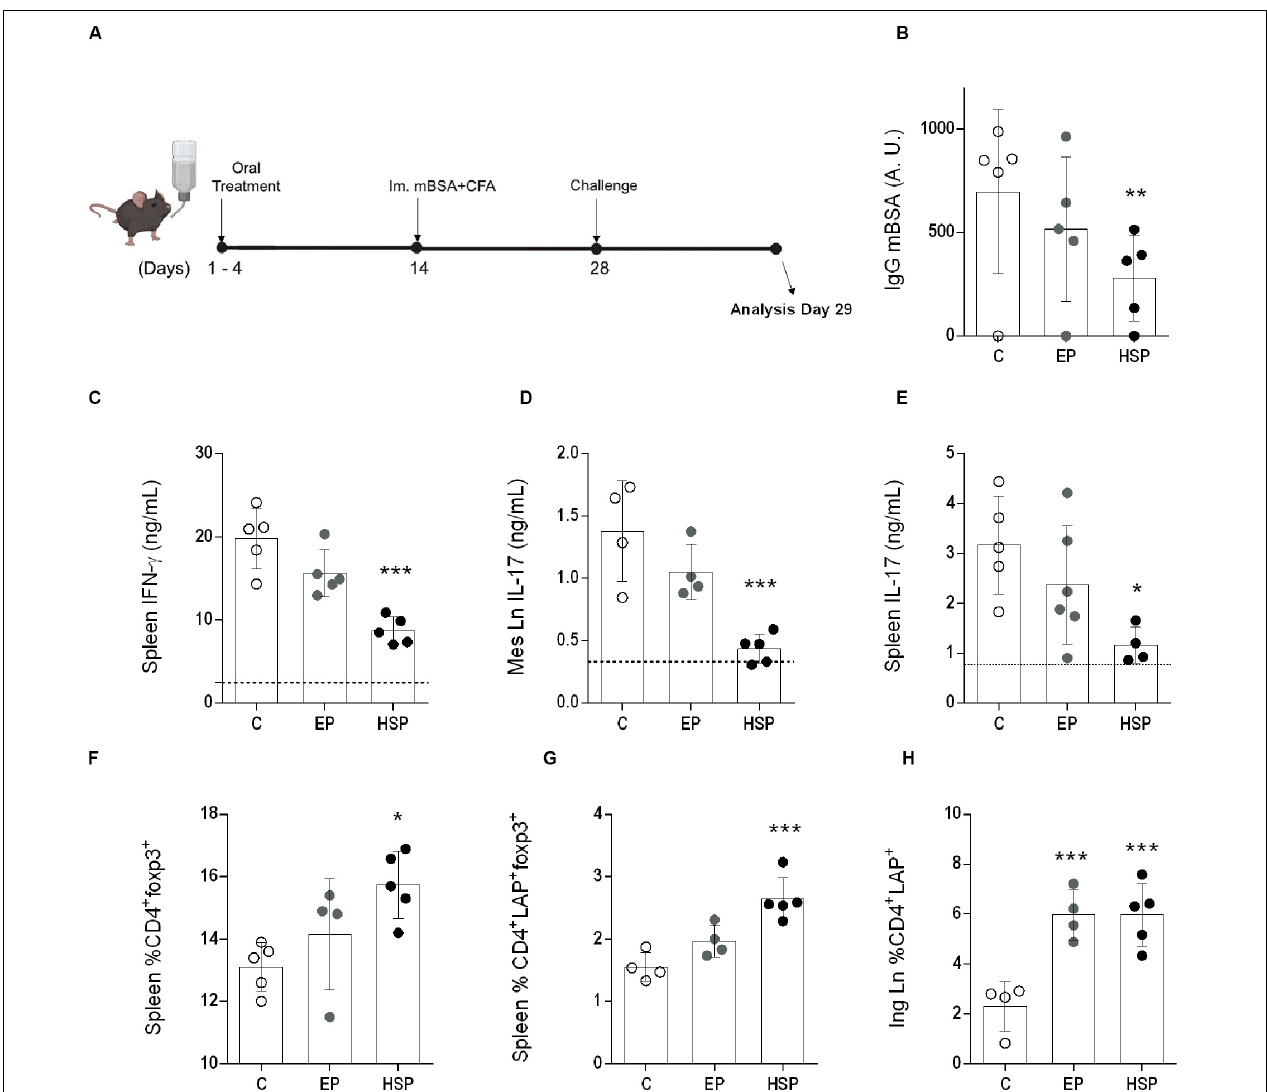
FIGURE 5 | Oral treatment with Hsp65-producing L. lactis prevented mBSA induced arthritis (AIA). (A) Female C57BL/6 mice were fed either XM17 broth (group C), L. lactis -EP (group EP) or Hsp65-Lac (HSP Group) for four days. Ten days afterward, arthritis was induced by a subcutaneous immunization with mBSA in CFA. Two weeks later, mice were injected with mBSA directly into the knee and 24 h after were euthanized. (B) Serum anti-mBSA total IgG levels measured by ELISA. (C) IFN- γ measured from spleen cell cultures stimulated with mBSA. (D) IL-17 from mBSA stimulated cell cultures from mesenteric lymph nodes and (E) spleen. (F) CD4+CD25+ from Spleen and marked for Foxp3+ and (G) Foxp3+LAP+. (H) Inguinal lymph node CD4+LAP+. Values represent the mean ± SEM. * p < 0.05 in relation to the control group C. ** p < 0.005 compared to the control group